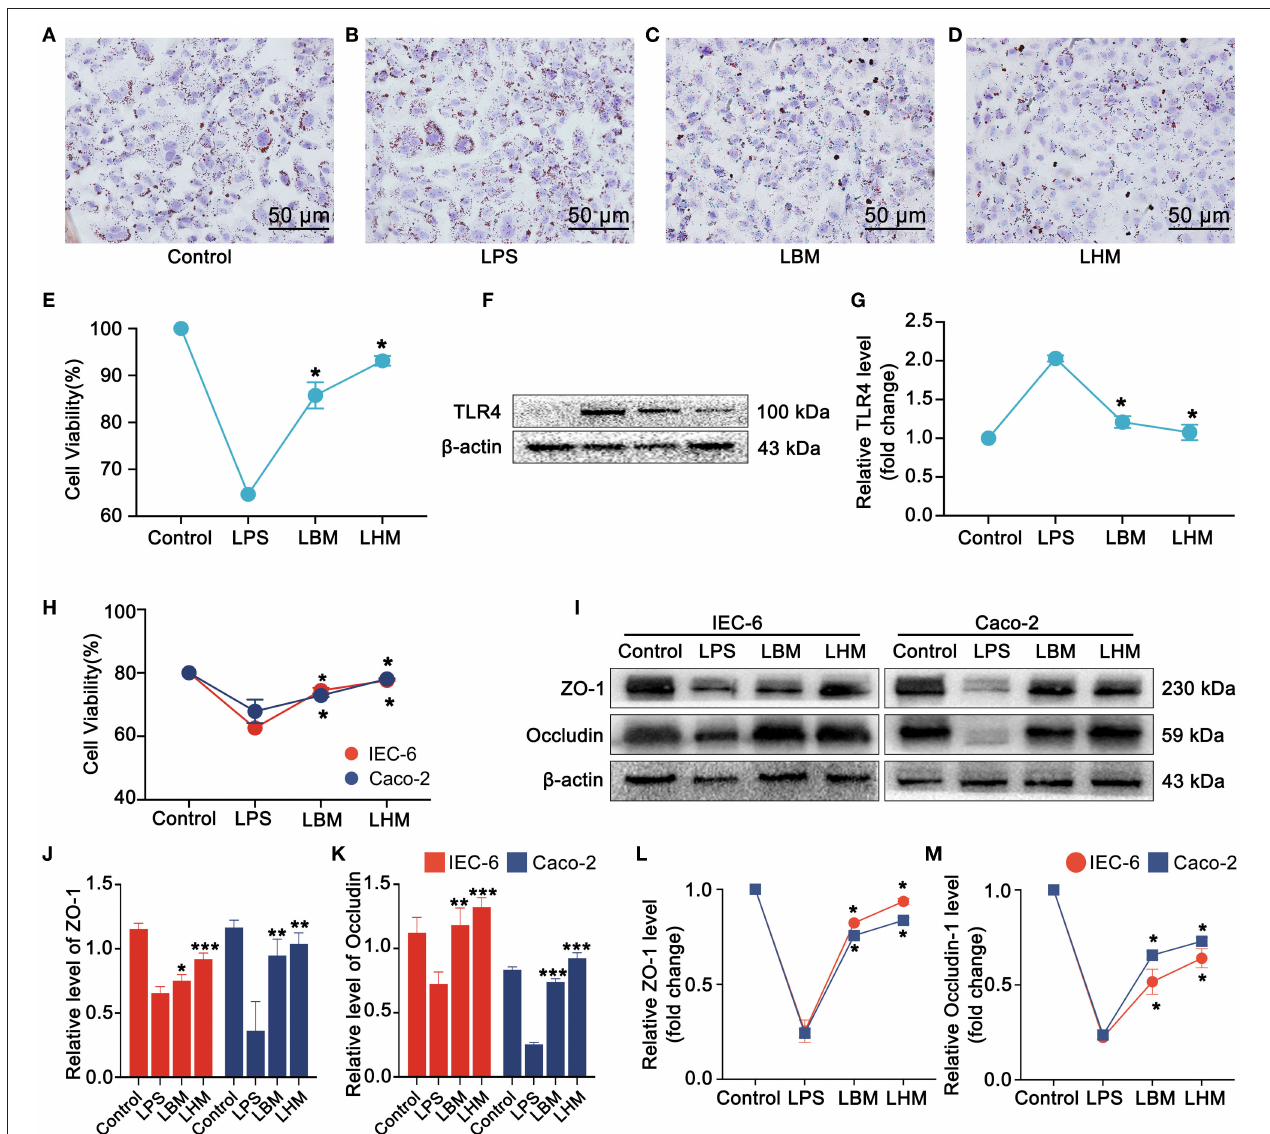
FIGURE 4 | HO-1/BMMSCs repair LPS-injured steatotic hepatocytes and intestinal epithelial cells. (A) Normal IAR-20 cells with steatosis, stained with oil red ( × 200). (B) LPS-stimulated steatotic IAR-20 cells with increased positive oil red staining. (C) After LPS-stimulated steatotic IAR-20 cells were co-cultured with BMMSCs, the positive staining of oil red decreased significantly. (D) After LPS-stimulated steatotic IAR-20 cells were co-cultured with HO-1/BMMSCs, the positive oil red staining decreased significantly. (E) Cell viability of steatotic IAR-20 cells in each group. (F) Changes of TLR4 protein levels in steatotic IAR-20 cells in each group. (G) Expression levels of Tlr4 mRNA in steatotic IAR-20 cells in each group. (H) Cell viability of IEC-6 and Caco-2 cells in each group. (I–K) Protein levels of tight junction proteins (ZO-1, Occludin) in each group. (L,M) mRNA levels of claudin ( Zo1 , Ocln ) in each group. * P < 0.05 vs. LT group, ** P < 0.01 vs. LT group, *** P < 0.001 vs. LT group, **** P < 0.0001 vs. LT